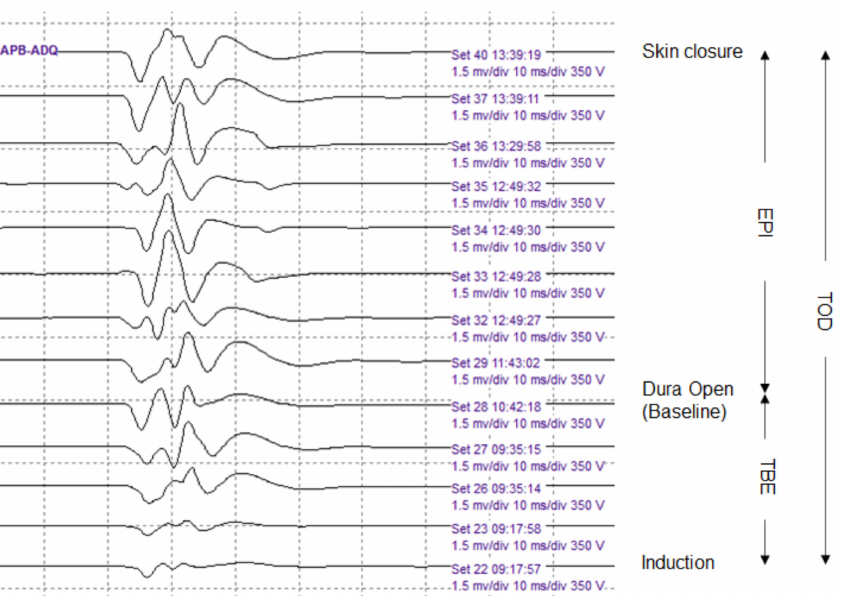
Figure 3. Serial abductor pollicis brevis motor evoked potentials (APB-MEPs) during the surgery.